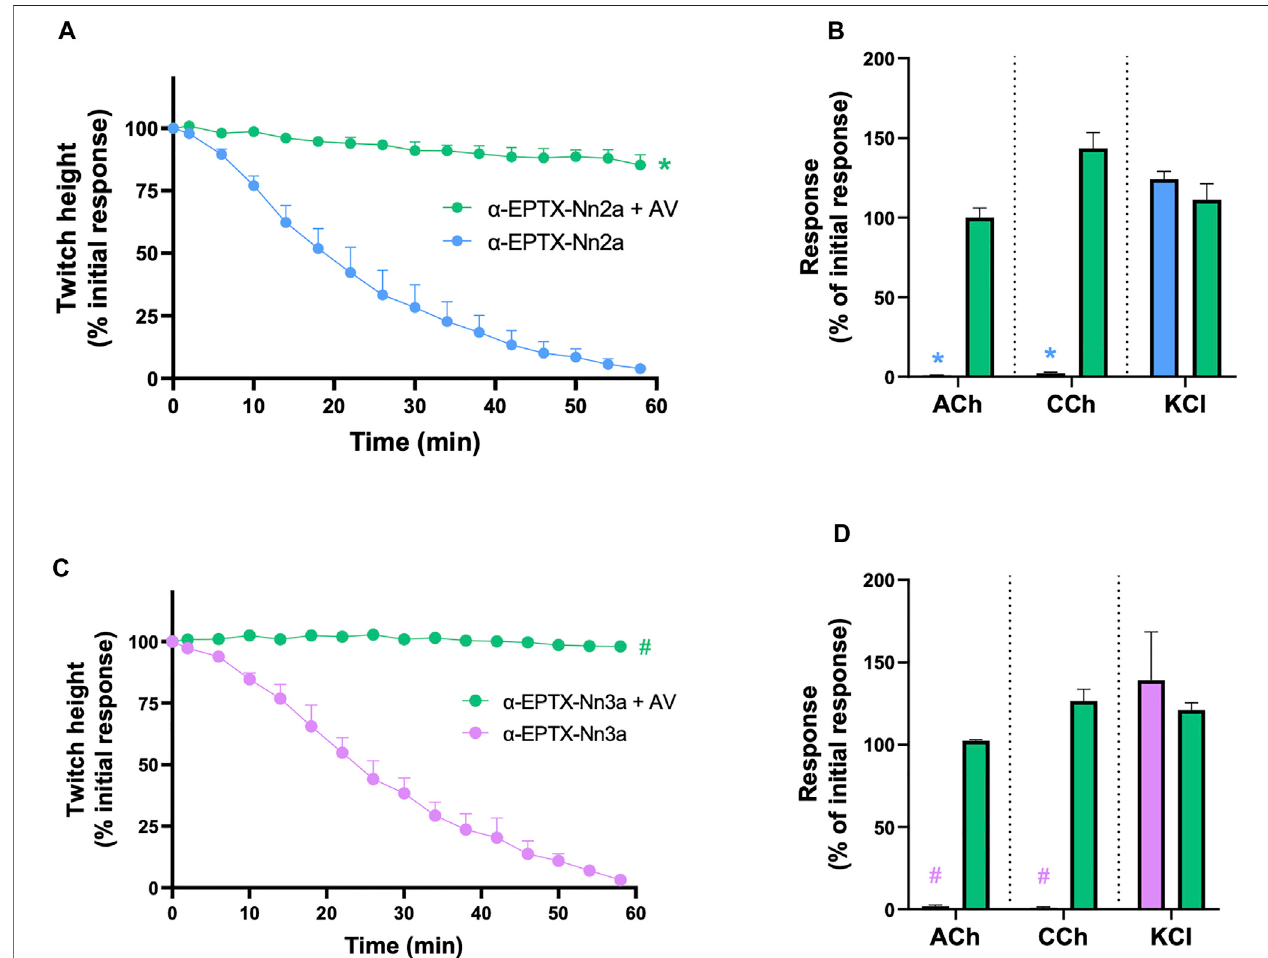
FIGURE 6 | The effect of pre-addition of Indian Polyvalent antivenom (AV; at the recommended dose; 1 ml/0.6 mg) on the neurotoxicity of α -Elapitoxin-Nn2a (100 nM) and α -Elapitoxin-Nn3a (100 nM). Panels (A) and (C) show that the antivenom prevents the neurotoxicity of both α -Elapitoxin-Nn2a and α -Elapitoxin-Nn3a, respectively.Panels (B) and (D) showthattheantivenompreventsthereductionofresponsestoACh(1 mM)andCCh(20 µM)inthechickbiventercervicisnerve-muscle preparation by α -Elapitoxin-Nn2a and α -Elapitoxin-Nn3a, respectively. The response to KCl (40 mM) is unaffected by α -Elapitoxin-Nn2a and α -Elapitoxin-Nn3a. * p < 0.05, signi fi cantly different from (A) α -Elapitoxin-Nn2a alone at 60 min (unpaired t -test; n = 5) or (B) response to same agonist before α -Elapitoxin-Nn2a addition (paired t -test, n = 5). # p < 0.05, signi fi cantly different from (C) α -Elapitoxin-Nn3a alone at 60 min (unpaired t -test; n = 5) or (D) response to same agonist before α - Elapitoxin-Nn3a addition (paired t -test, n =